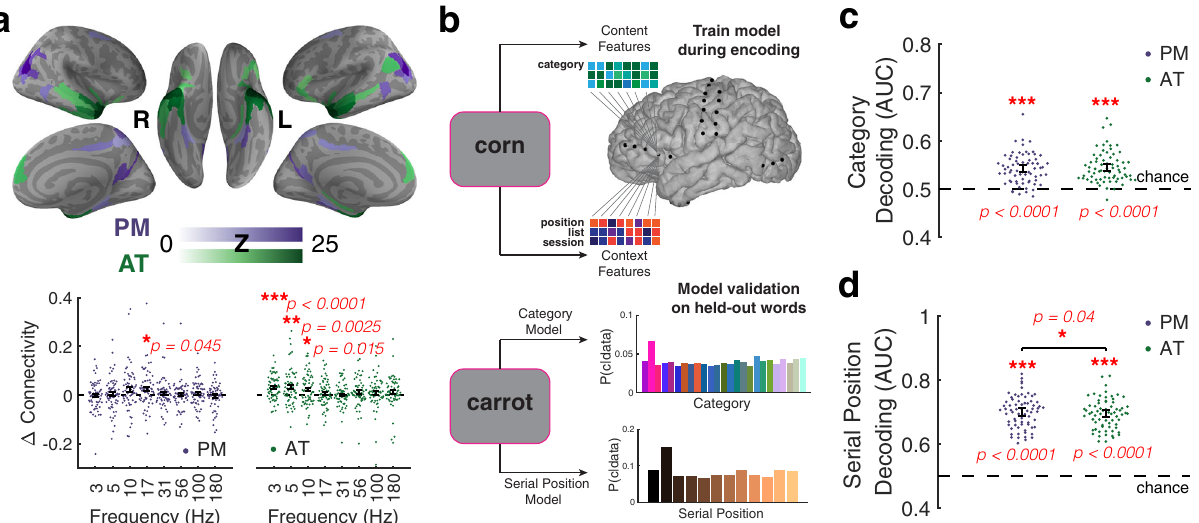
Fig. 2 Network-based decoding of content and context. a rsfMRI connectivity identi fi es distinct cortical networks. Top: Functional connectivity (Fisher Z) to cortical targets of the PM and AT networks across right (R) and left (L) hemispheres. Bottom: Difference in connectivity of recording sites within versus between the two networks. Frequency speci fi city was observed within each network. b Modeling schematic. Ridge regression modeled evoked neural activity during stimulus encoding. Models were validated by decoding the category and serial position of held-out stimuli during encoding. c Reliable category decoding in the PM and AT networks during encoding. d Accurate serial position decoding for the PM and AT networks during encoding. Statistical inference was performed with two-sided, permutation t tests versus zero with FWER correction for multiple comparisons ( a ) or with one-sided sign tests versus chance ( c , d ). For all tests, n = 69 subjects. Data are presented as mean values ± SEM. * p < 0.05, ** p < 0.01, *** p < 0.001. Source data are provided as a Source Data fi